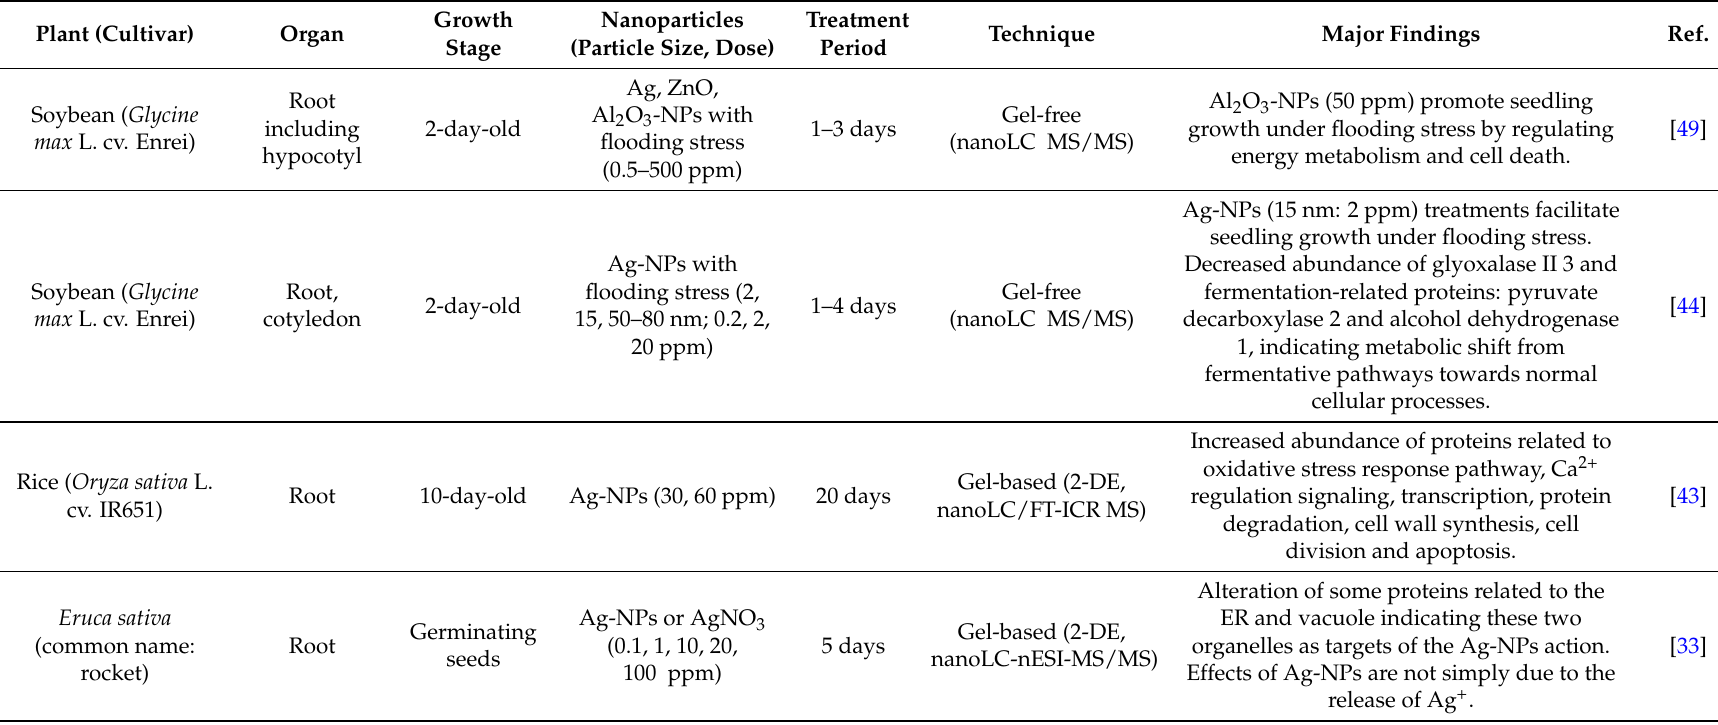
Table 2. Summary of proteomic analyses in response to nanoparticle